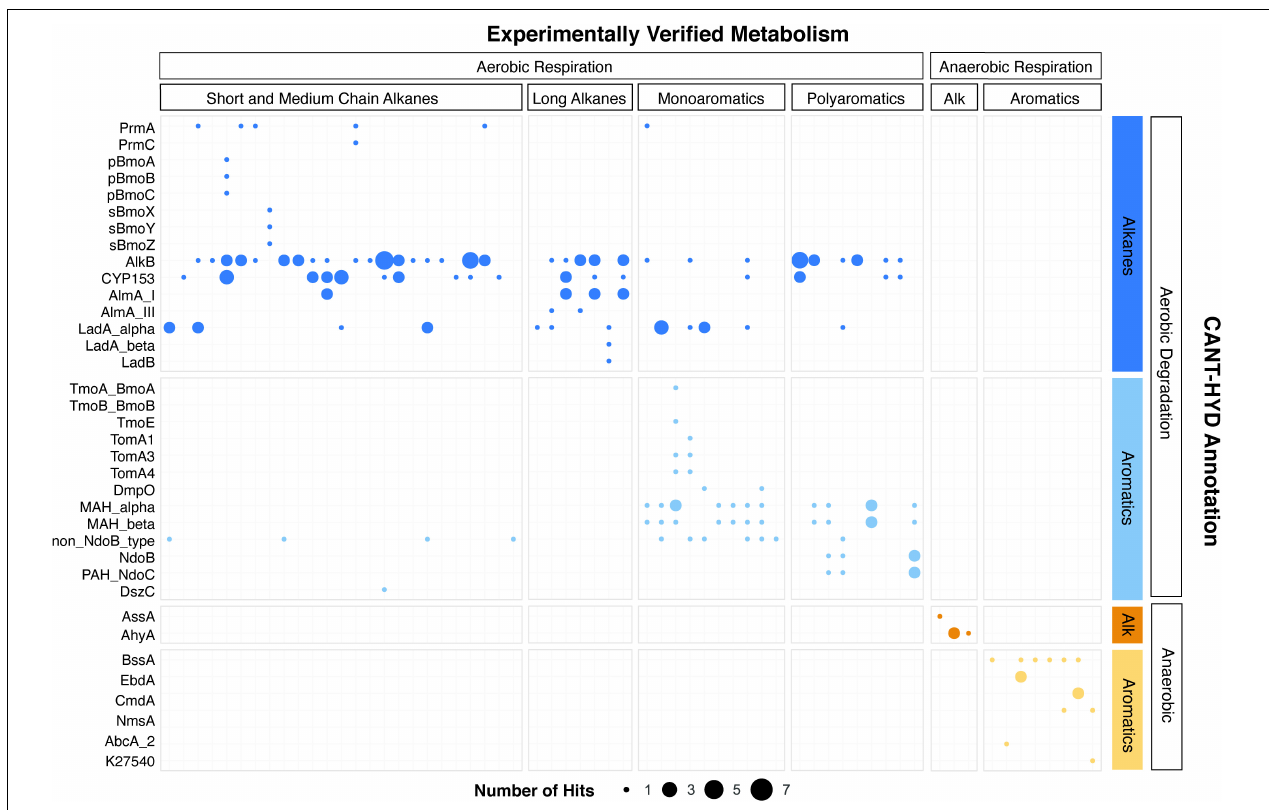
FIGURE 3 | Concordance of CANT-HYD annotations of genomes and their experimentally verified hydrocarbon degradation activity. Each bubble represents hits above the confidence threshold from experientially verified hydrocarbon degrading genomes (x-axis) plotted against the HMMs of the CANT-HYD database (y-axis). The size of the bubble represents number of unique hits in the genome. The genomes (x-axis) and the CANT-HYD HMMs (y-axis) are organized by the hydrocarbon substrate and respiration. A complete list of isolate genomes, their Genbank accession, and their published hydrocarbon degradation capability can be found in Supplementary Table 3